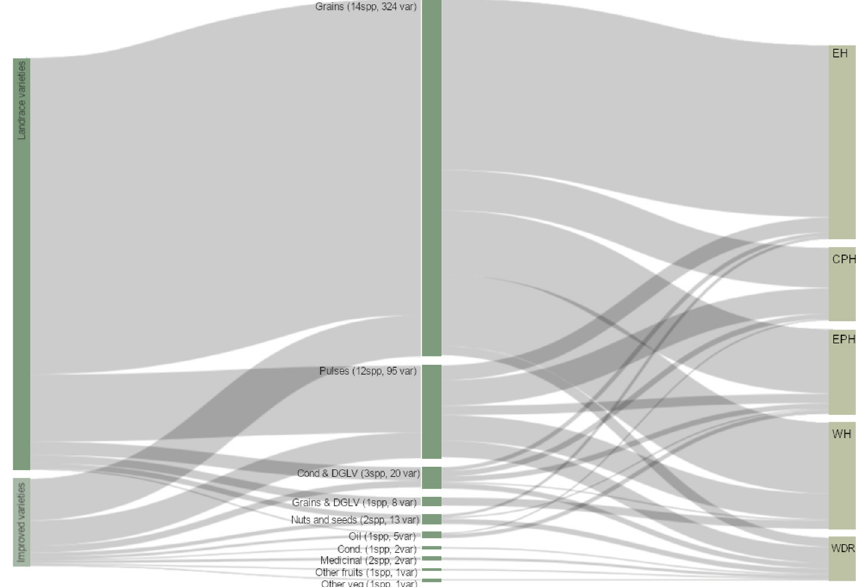
Figure 6. Sanki diagram showing the varietal flow and distribution between the type (landrace or improved/released) across food groups and the agroecological zones. Each food group includes the number of species (spp) and varieties (var) listed. Food groups include grains (e.g., wheat, barley, millets, maize, sorghum, and rice); pulses (e.g., gram, lentils, beans, and peas); condiments and DGLV, which are condiments, seasonings, and dark green leafy vegetables (e.g., mustard and fenugreek); grains and DGLV, which are grains and dark green leafy vegetables (e.g., amaranth); nuts and seeds (e.g. sesame and groundnut); oil (e.g., niger); medicine (e.g., Ricinus and Isabgol); other fruits (e.g., watermelon); and other vegetables (e.g., cucumber). Abbreviations: EH, Eastern Himalayan; EPH, Eastern Plateau and Hills; WH, Western Himalayan; CPH, Central Plateau and Hills; and WDR, Western Dry Region.